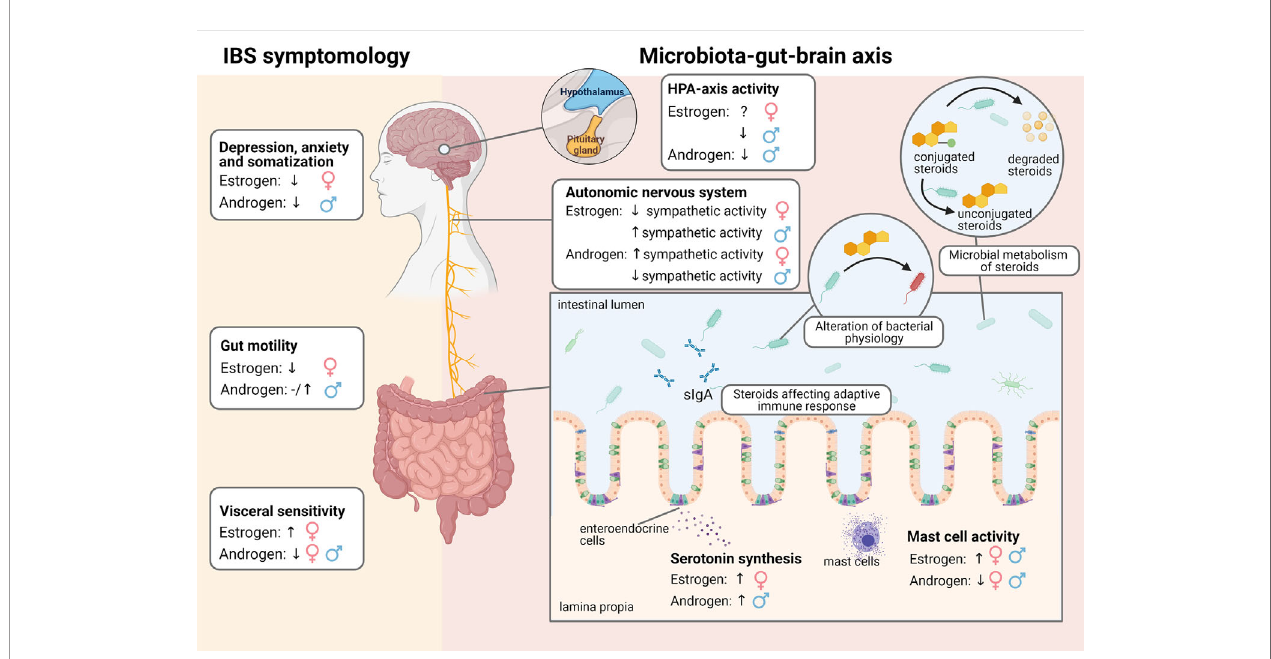
FIGURE 1 | Effect of estrogens and androgens on IBS symptomology and the microbiota-gut-brain axis in males and